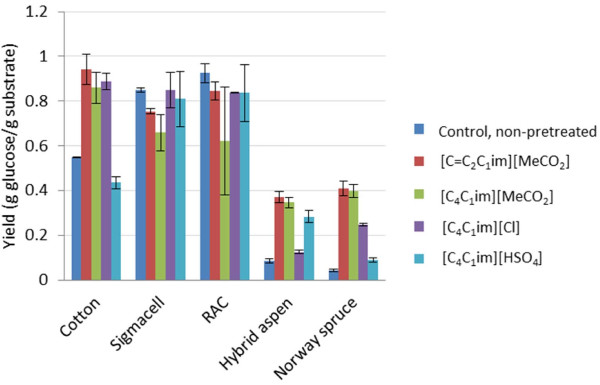
The glucose yield in g glucose g substrate
-1
after 72 h of enzymatic hydrolysis (at the end of the reactions after that the reaction rates level off) of ionic-liquid-pretreated samples and non-pretreated control.